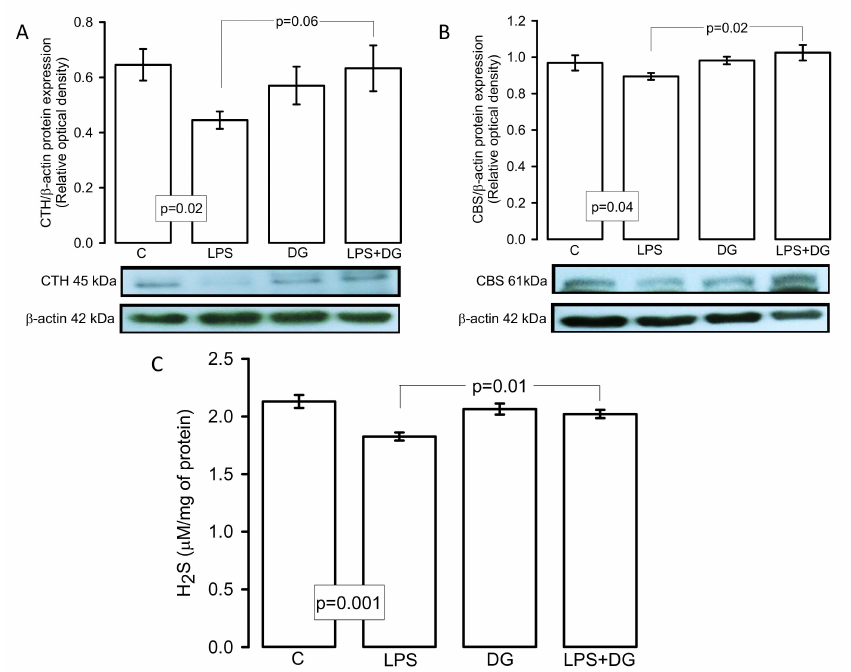
Figure 4. Expressions of the ( A ) CTH expression, ( B ) CBS expression, and ( C ) H 2 S concentra- tion. Values are expressed as mean ± SE (n = 6). Abbreviations: C = control, DG = deodorized garlic, LPS = lipopolysaccharide, CBS = cystathionine synthetase, CTH = cystathionine γ -lyase, H 2 S = hydrogen